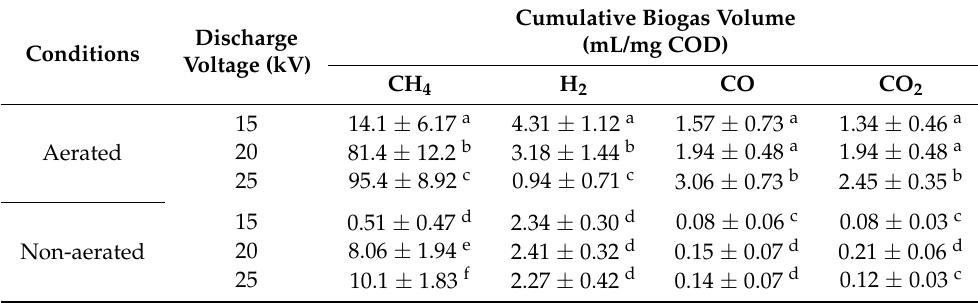
Table 2. The average cumulative biogas volume produced from POME after DBD treatment un- der aerated and non-aerated conditions at different discharge voltages. The values are shown in mean with standard deviation. The different letters (a–f) indicate that the observed differences are statistically significant at p <